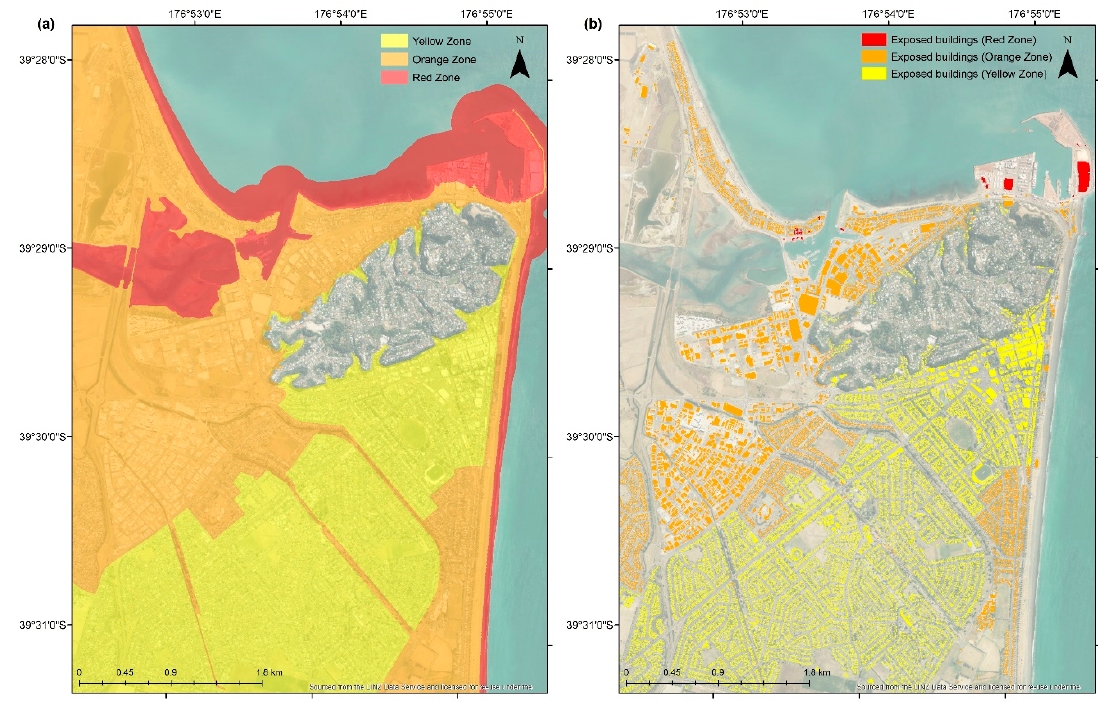
Figure 3. Tsunami evacuation zones and building exposure for Napier City (Hawke’s Bay, North Island, New Zealand), showing ( a ) red, orange and yellow zones; and ( b ) buildings exposed in each zone.